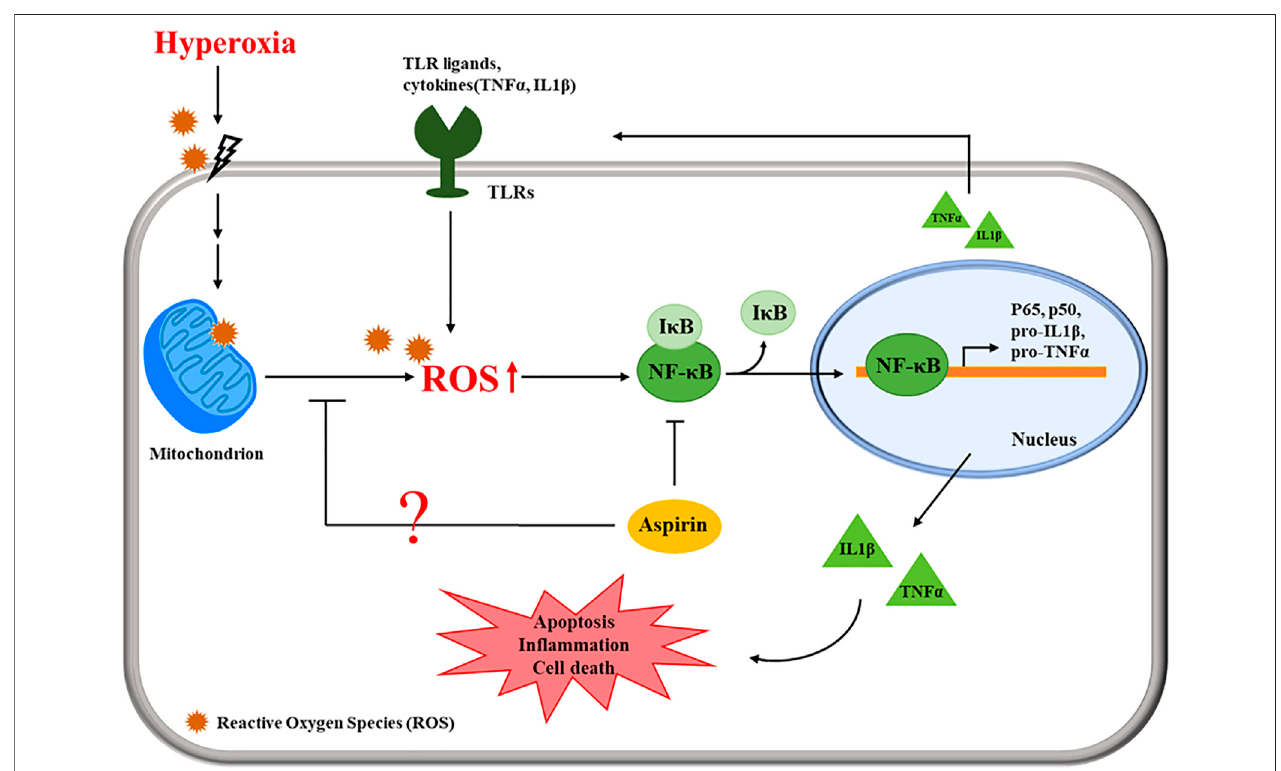
FIGURE 8 | Schematic of the pathway by which the aspirin posttreatment regulates hyperoxia-induced acute respiratory distress syndrome (ARDS) by suppressing pulmonary in fl ammation via NF- κ B signaling.